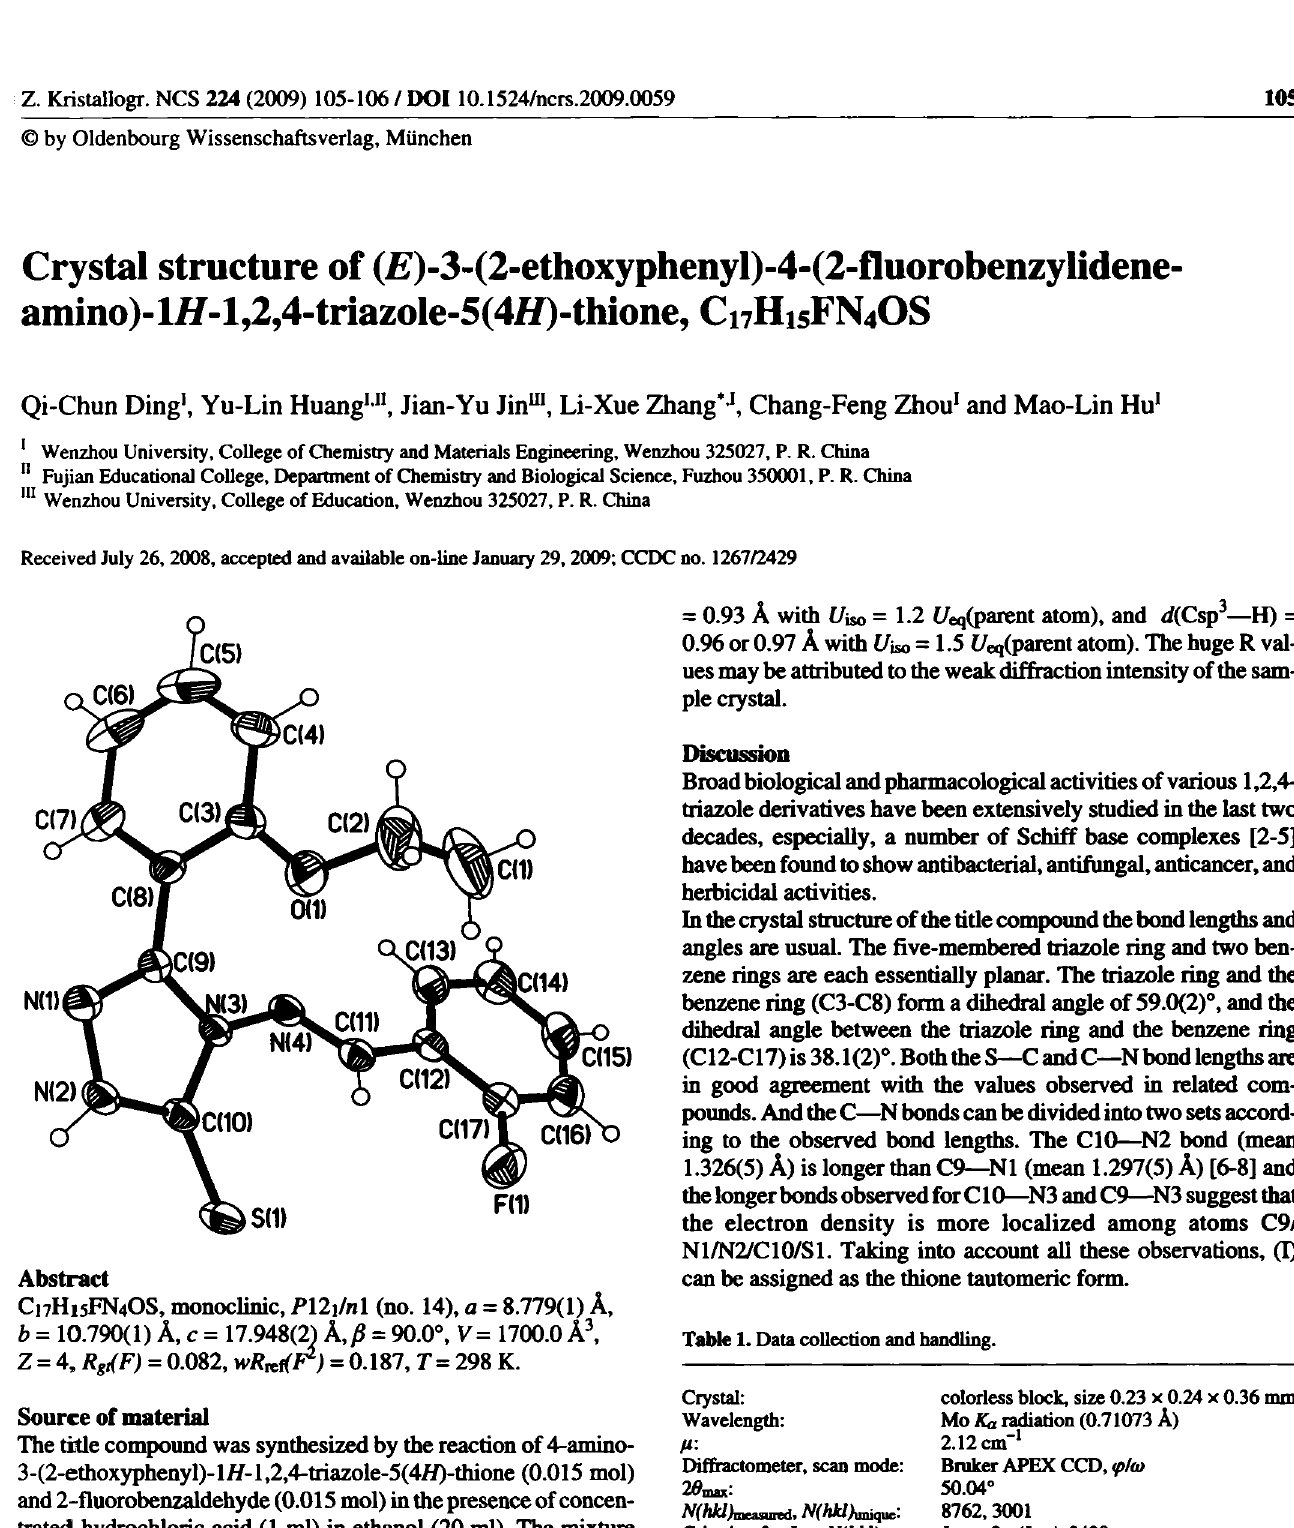
Table 2. Atomic coordinates and displacement parameters (in Â 2